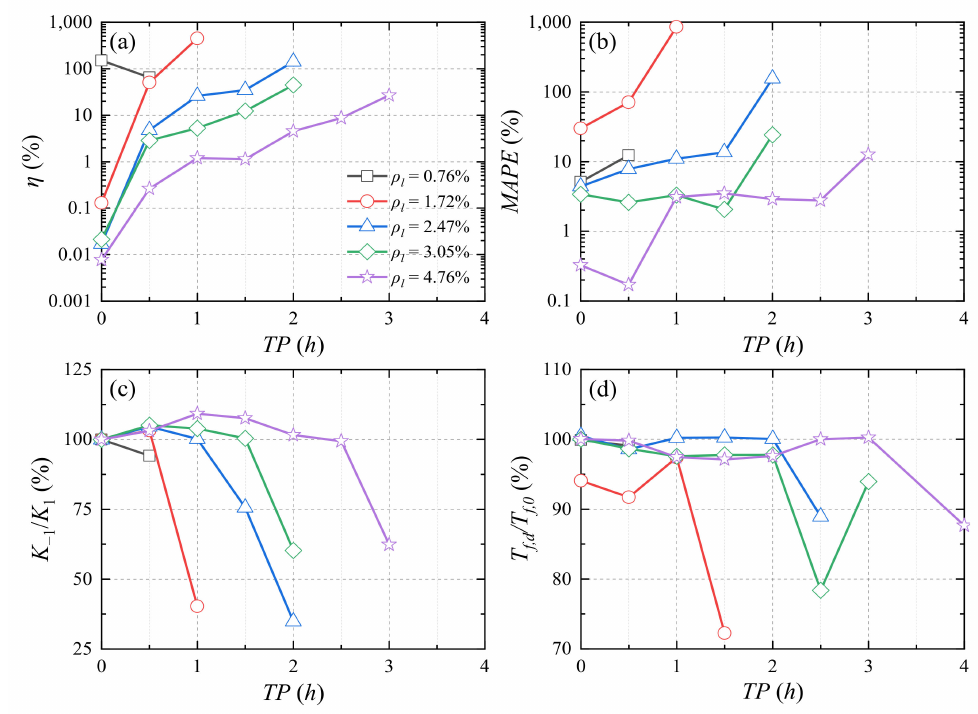
Figure 21. Impact of cyclic load on the response of different longitudinal reinforcement ratio ( ρ l ) of RC column during fire exposure: ( a ) cyclic load effect coefficient η ; ( b ) MAPE ; ( c ) stiffness degradation ratio; ( d ) fire resistance time ratio.